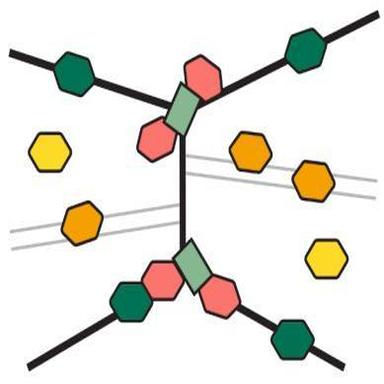
A schematic outlining the criteria that are used to classify the recrystallised grains into groups depending on their location.